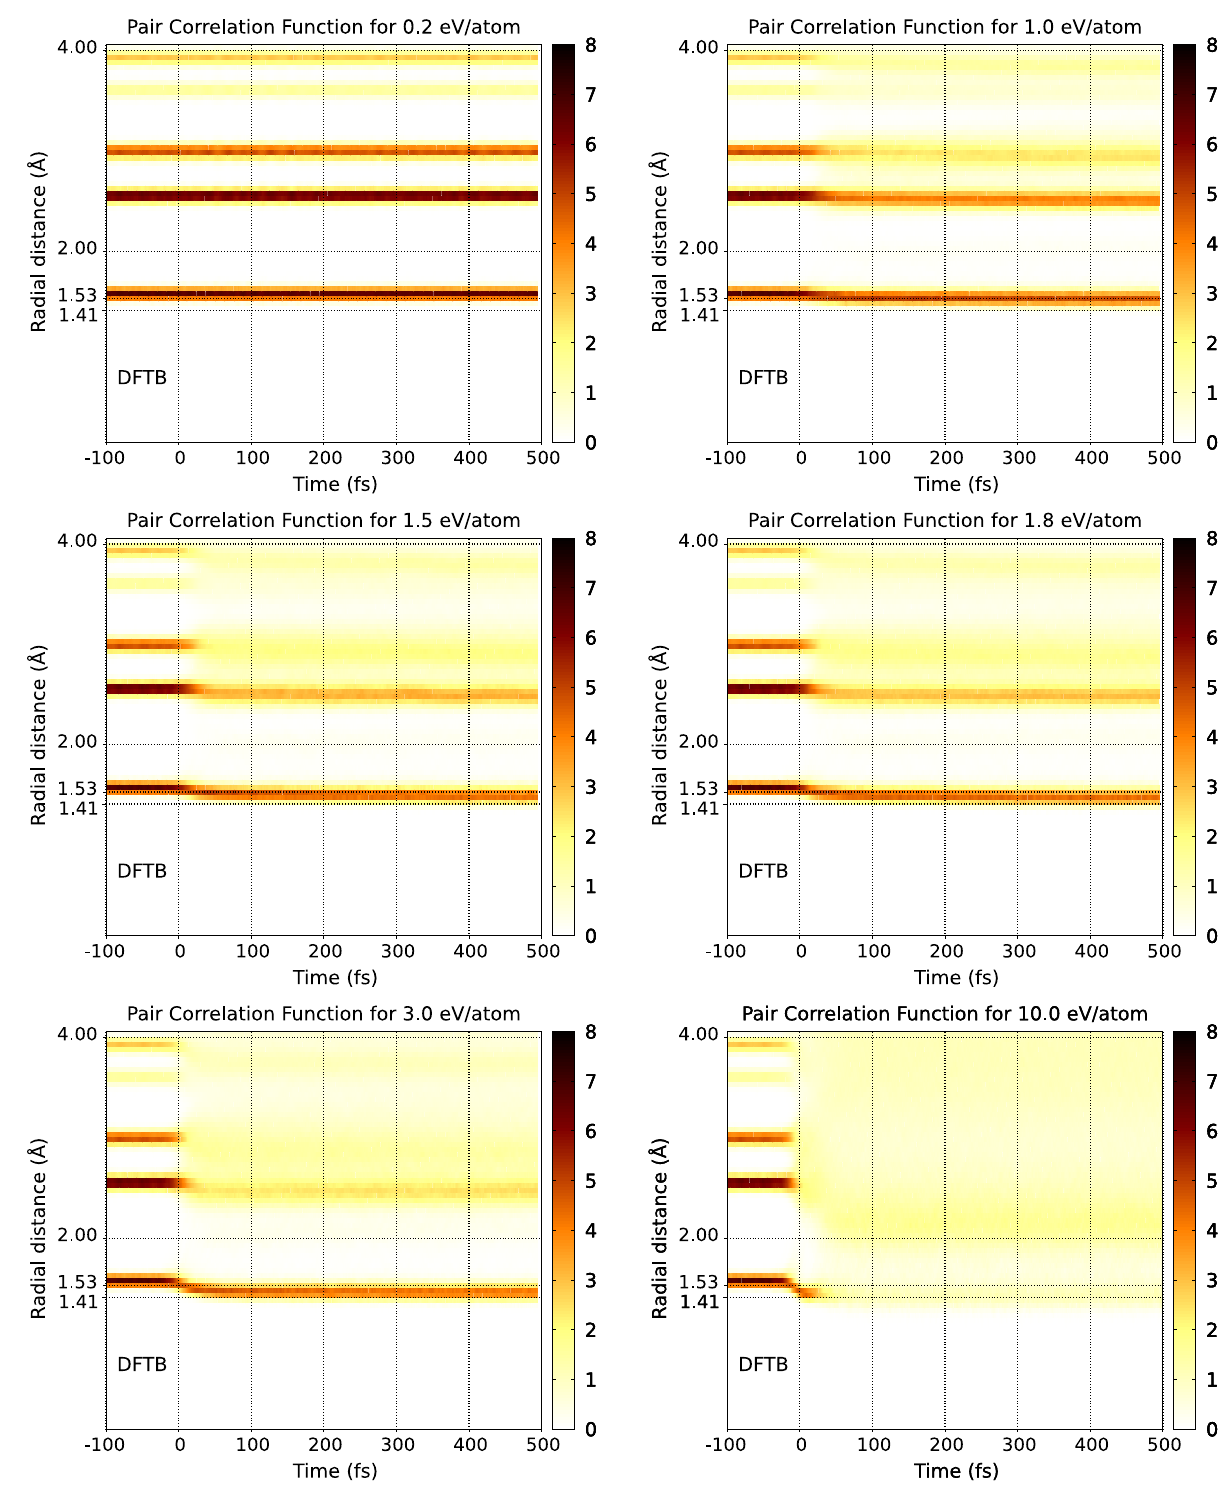
Figure 3. Temporal evolution of pair correlation function for various X-ray absorbed doses in diamond bulk as predicted by XTANT+ . Pulse and supercell parameters are the same as in Fig. 2. The figure has been generated using gnuplot 5.0 patchlevel 6 (http:// gnupl ot.